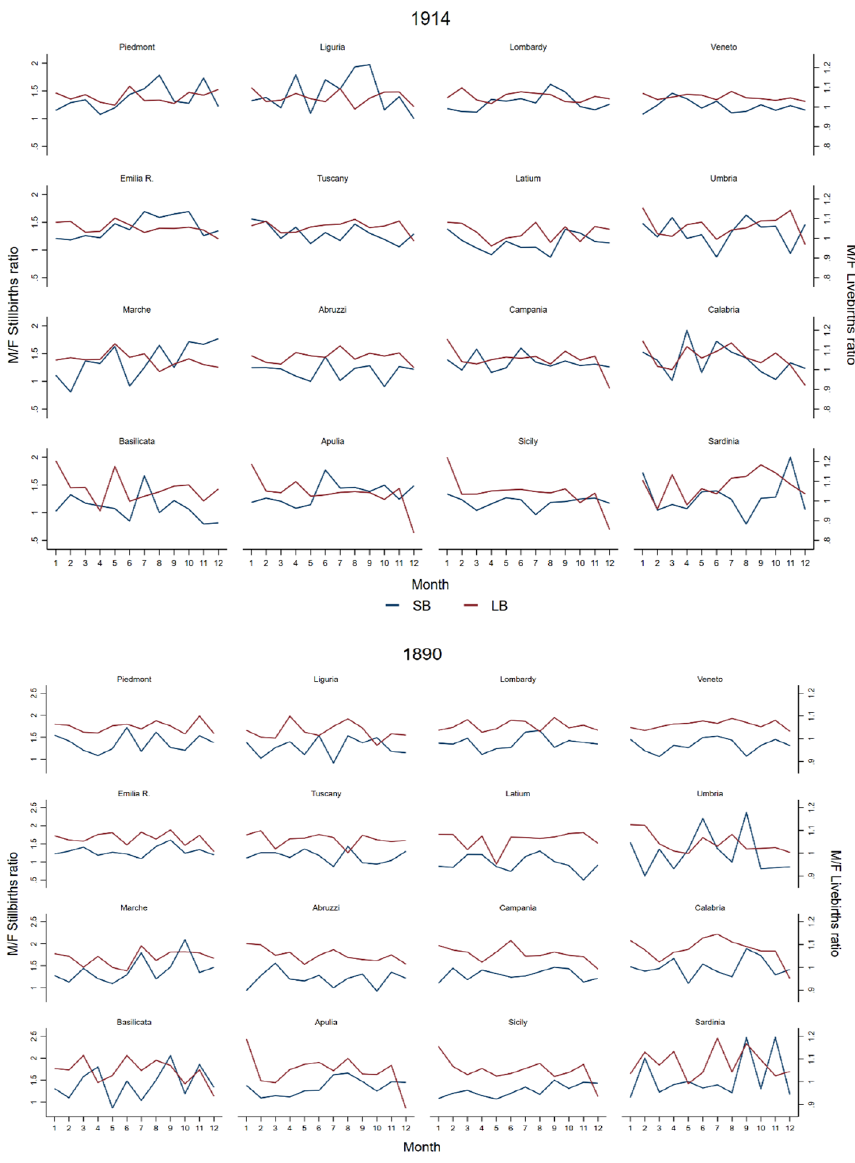
Fig. 3 M/F ratio for stillbirths and live births in the Italian regions, 1890,